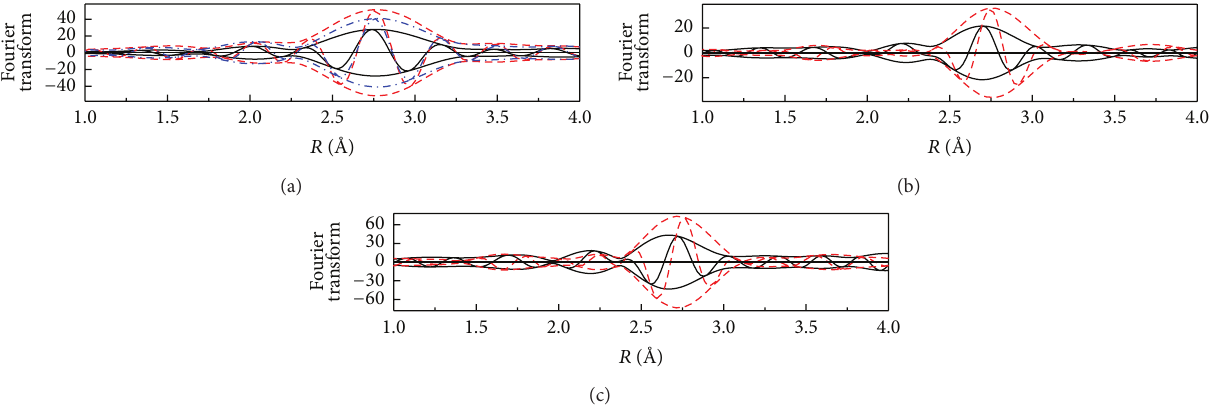
−1 Figure 9: Comparison of (a) imaginary part and magnitude of Fourier transform ( 𝑘 3 -weighted, 3.0 < 𝑘 < 9.5 ˚A , Pt-Pt phase and amplitude (black line), Pt foil (red line), and Pt/ 𝛾 -Al 2 O 3( (blue line); (b) corrected) of experimental EXAFS data at Pt edge for Pt-Re/ 𝛾 -Al 2 O 3( d ) d ) −1 , Re-Re ( phase and amplitude corrected) of imaginary part and magnitude of Fourier transform ( 𝑘 3 -weighted, 4.0 < 𝑘 < 14 ˚A theortical ) andRe/ 𝛾 -Al 2 O 3( (redline);(c)imaginarypartandmagnitudeofFouriertransform experimentalEXAFSdataatReedgeforPt-Re/ 𝛾 -Al 2 O 3( d ) d ) −1 , Re-Re ( phase and amplitude corrected) of experimental EXAFS data at Re edge for Pt-Re/ 𝛾 -Al 2 O 3( ( 𝑘 3 -weighted, 4.0 < 𝑘 < 14 ˚A experimental ) d ) and Re/ 𝛾 -Al 2 O 3( (red d )